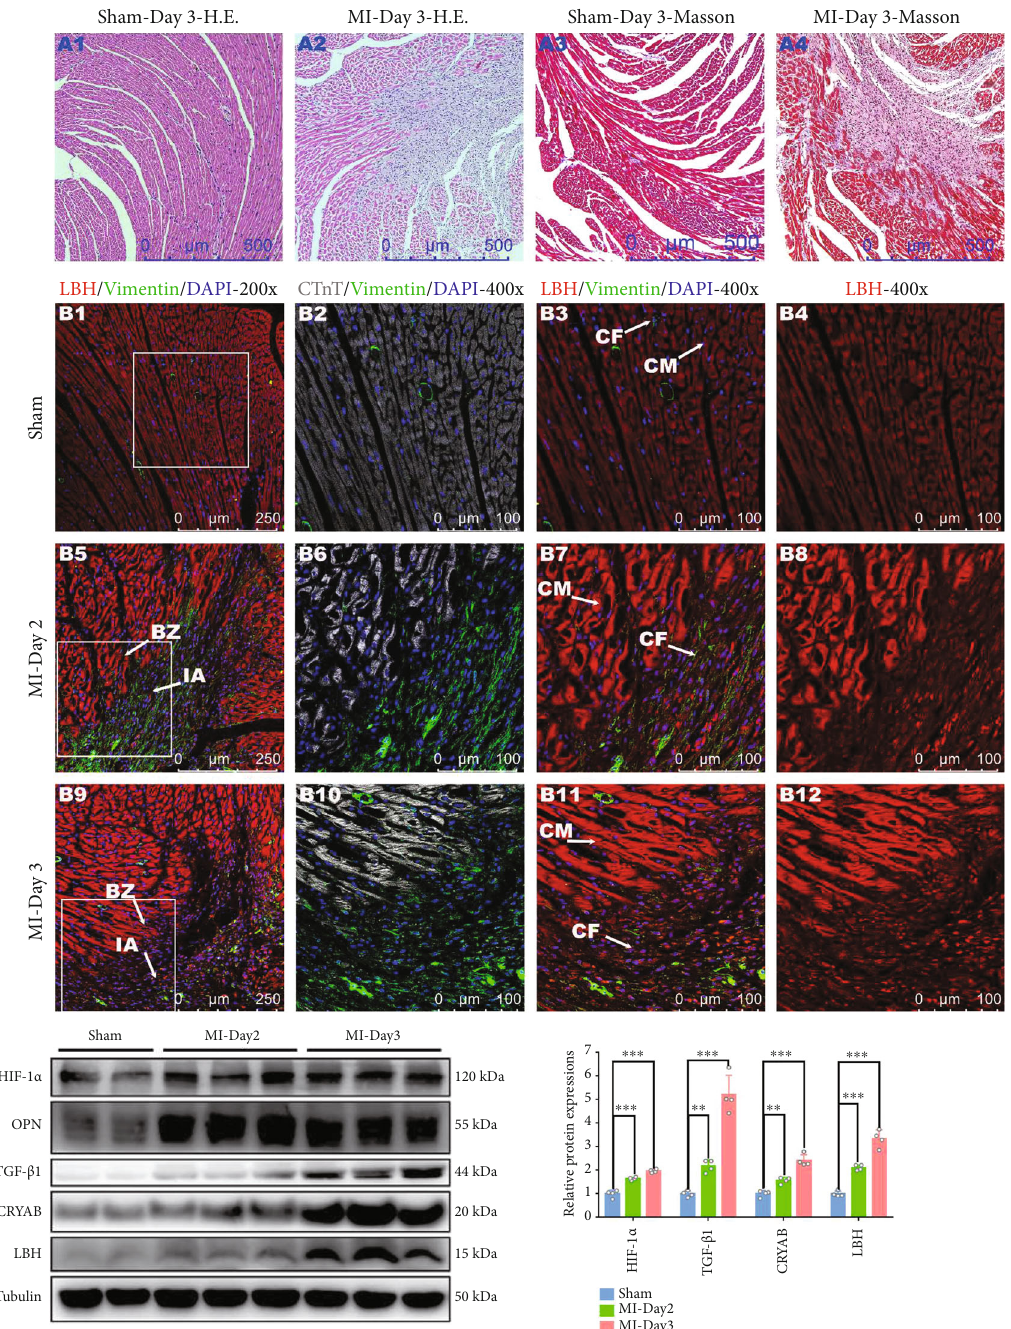
Figure 1: Protein expression of LBH, CRYAB, and TGF- β 1 in heart tissue from the mouse MI model during post-MI infarct healing. (a) Cross sections of hearts from the sham and MI groups at the indicated time points after surgery were subjected to H&E and Masson staining. (b) The same heart sections were costained with anti-LBH (red) and anti-vimentin (green) or with anti-LBH (red) and anti- CTnT (gray) antibodies. Typical CFs (vimentin + /CTnT - ), CMs (vimentin - /CTnT + ), infarct areas (IAs), and infarct border zones (BZs) were indicated by white arrows. (c) Protein expression levels of HIF-1 α , OPN, TGF- β 1, LBH, and CRYAB in the peri-infarct heart tissue at the indicated time points after surgery ( ∗∗ p < 0 : 01 and ∗∗∗ p < 0 : 001 vs. Sham